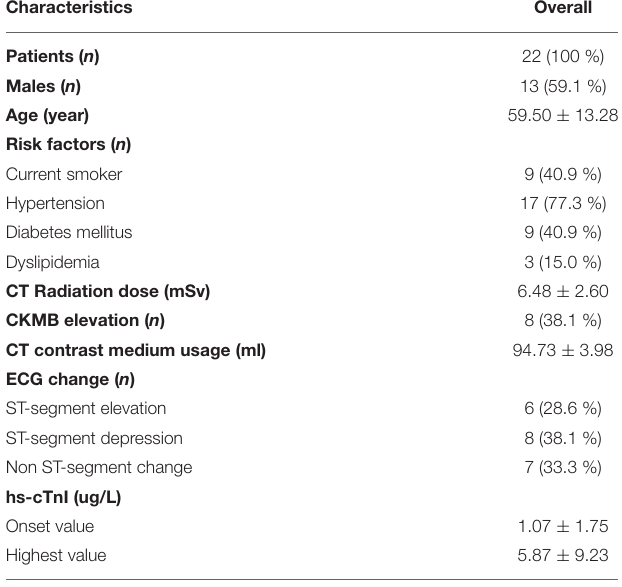
TABLE 1 | Clinical